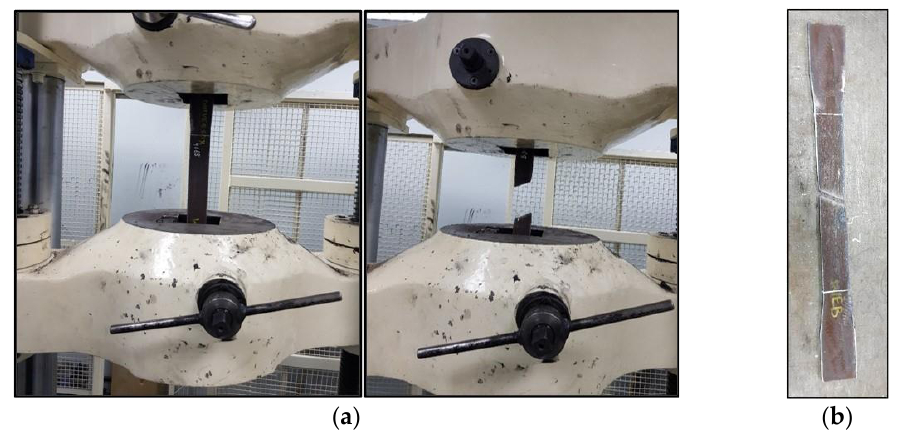
Figure 3. Photos of a typical steel coupon: ( a ) during testing; ( b ) after testing.